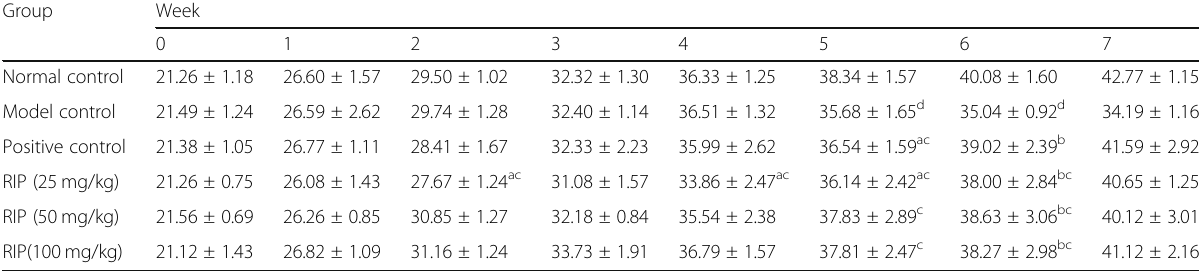
Table 2 Effects of increasing age and different treatments on the body weights (g) of ICR mice Group Normal control Positive control